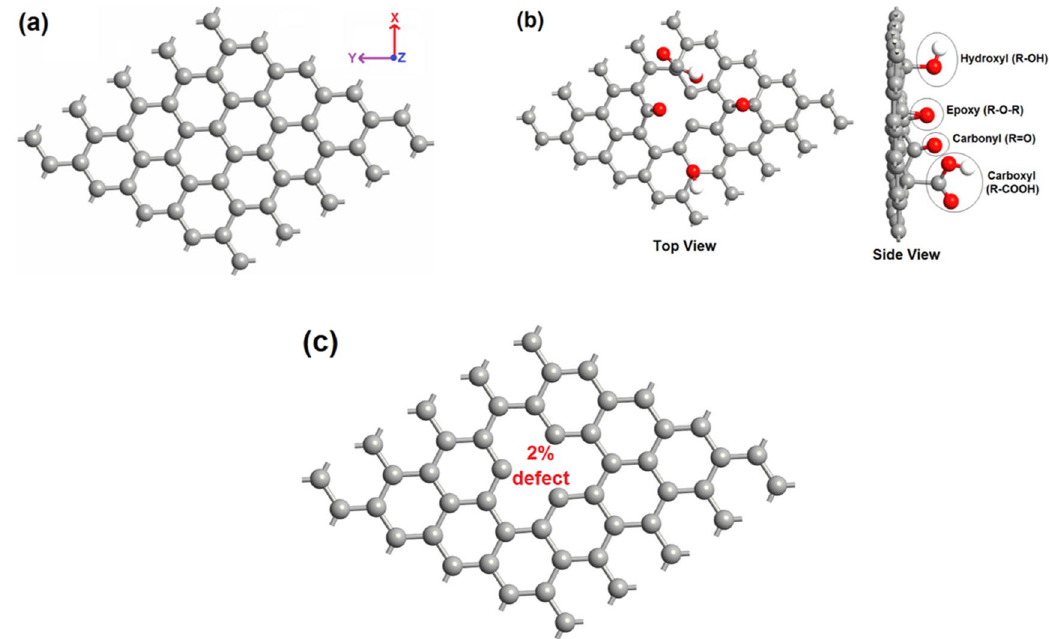
Figure 3. ( a ) 5 × 5 hexagonal periodic supercell of pristine GNs. ( b ) Defected GO with defect concentration of 2%. ( c ) Defected GNs with defect concentration of